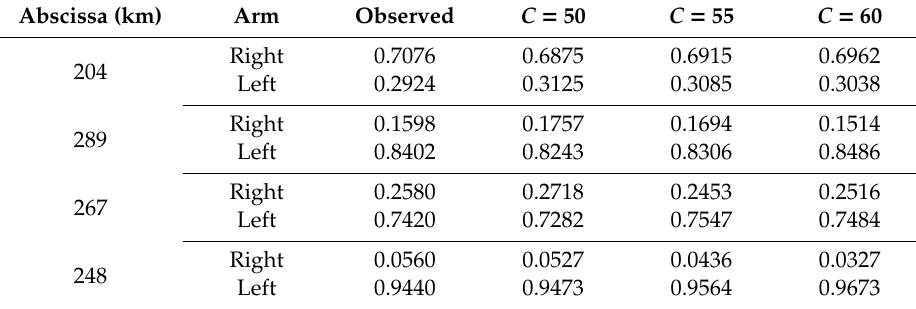
Table 2. Flow distribution through river branches around islands of the river reach.